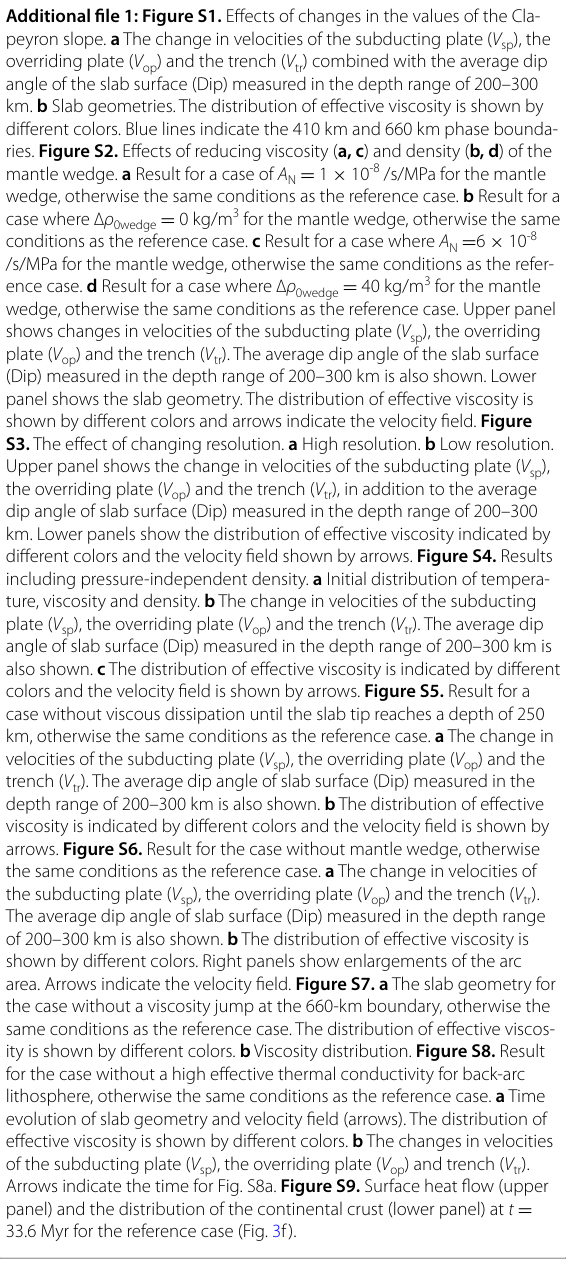
Additional file 1: Figure S1. Effects of changes in the values of the Cla- peyron slope. a The change in velocities of the subducting plate ( V sp ), the overriding plate ( V op ) and the trench ( V tr ) combined with the average dip angle of the slab surface (Dip) measured in the depth range of 200–300 km. b Slab geometries. The distribution of effective viscosity is shown by different colors. Blue lines indicate the 410 km and 660 km phase bounda- ries. Figure S2. Effects of reducing viscosity ( a, c ) and density ( b, d ) of the mantle wedge. a Result for a case of A N 1 10 -8 /s/MPa for the mantle = × wedge, otherwise the same conditions as the reference case. b Result for a case where ∆ ρ 0wedge 0 kg/m 3 for the mantle wedge, otherwise the same = conditions as the reference case. c Result for a case where A N 6 10 -8 = × /s/MPa for the mantle wedge, otherwise the same conditions as the refer- ence case. d Result for a case where ∆ ρ 0wedge 40 kg/m 3 for the mantle = wedge, otherwise the same conditions as the reference case. Upper panel shows changes in velocities of the subducting plate ( V sp ), the overriding plate ( V op ) and the trench ( V tr ). The average dip angle of the slab surface (Dip) measured in the depth range of 200–300 km is also shown. Lower panel shows the slab geometry. The distribution of effective viscosity is shown by different colors and arrows indicate the velocity field. Figure S3. The effect of changing resolution. a High resolution. b Low resolution. Upper panel shows the change in velocities of the subducting plate ( V sp ), the overriding plate ( V op ) and the trench ( V tr ), in addition to the average dip angle of slab surface (Dip) measured in the depth range of 200–300 km. Lower panels show the distribution of effective viscosity indicated by different colors and the velocity field shown by arrows. Figure S4. Results including pressure-independent density. a Initial distribution of tempera- ture, viscosity and density. b The change in velocities of the subducting plate ( V sp ), the overriding plate ( V op ) and the trench ( V tr ). The average dip angle of slab surface (Dip) measured in the depth range of 200–300 km is also shown. c The distribution of effective viscosity is indicated by different colors and the velocity field is shown by arrows. Figure S5. Result for a case without viscous dissipation until the slab tip reaches a depth of 250 km, otherwise the same conditions as the reference case. a The change in velocities of the subducting plate ( V sp ), the overriding plate ( V op ) and the trench ( V tr ). The average dip angle of slab surface (Dip) measured in the depth range of 200–300 km is also shown. b The distribution of effective viscosity is indicated by different colors and the velocity field is shown by arrows. Figure S6. Result for the case without mantle wedge, otherwise the same conditions as the reference case. a The change in velocities of the subducting plate ( V sp ), the overriding plate ( V op ) and the trench ( V tr ). The average dip angle of slab surface (Dip) measured in the depth range of 200–300 km is also shown. b The distribution of effective viscosity is shown by different colors. Right panels show enlargements of the arc area. Arrows indicate the velocity field. Figure S7. a The slab geometry for the case without a viscosity jump at the 660-km boundary, otherwise the same conditions as the reference case. The distribution of effective viscos- ity is shown by different colors. b Viscosity distribution. Figure S8. Result for the case without a high effective thermal conductivity for back-arc lithosphere, otherwise the same conditions as the reference case. a Time evolution of slab geometry and velocity field (arrows). The distribution of effective viscosity is shown by different colors. b The changes in velocities of the subducting plate ( V sp ), the overriding plate ( V op ) and trench ( V tr ). Arrows indicate the time for Fig. S8a. Figure S9. Surface heat flow (upper panel) and the distribution of the continental crust (lower panel) at t = 33.6 Myr for the reference case (Fig.